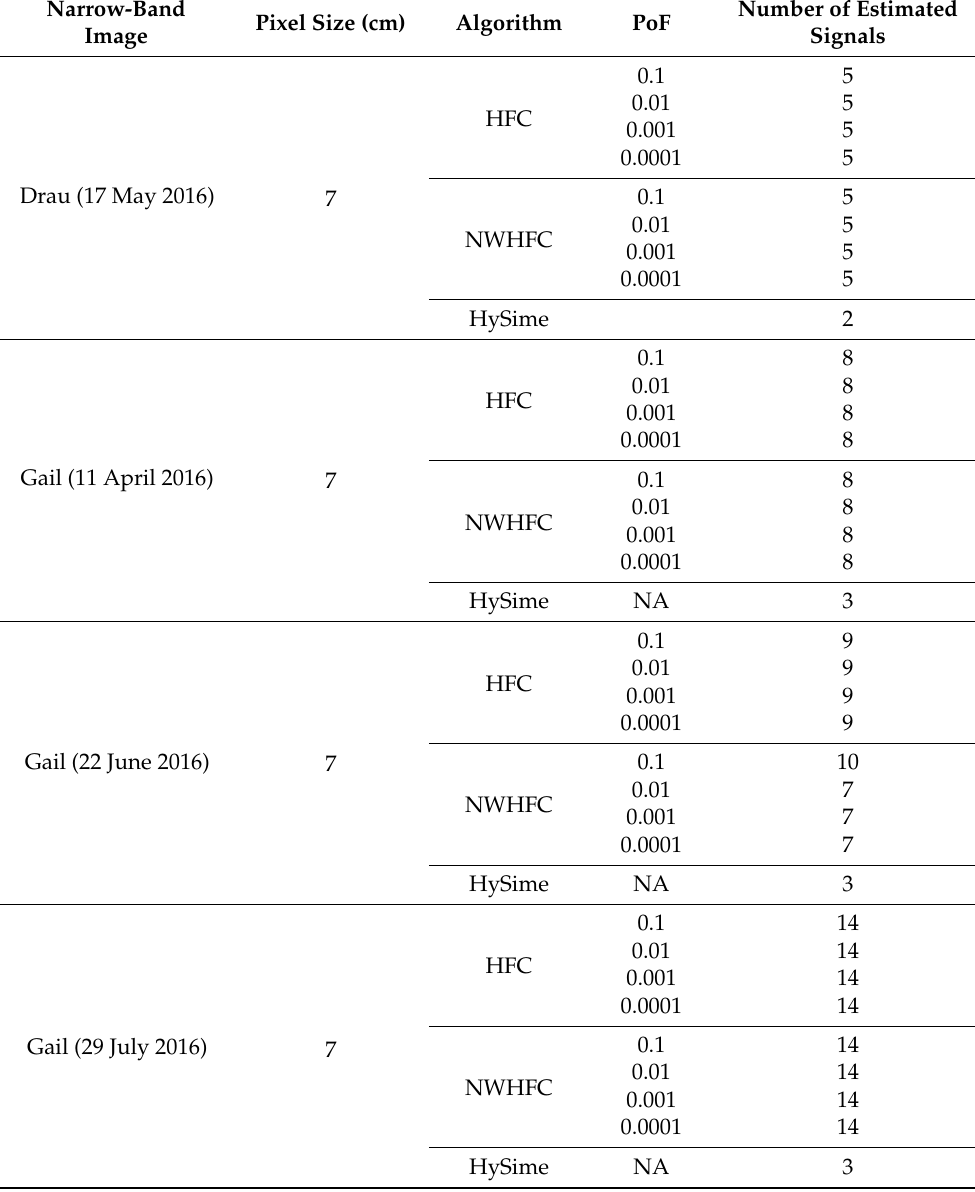
Table 5. The number of signals estimated by each algorithm and probability of failure (PoF) specifica- tion within each narrow-band image mosaic with 7 cm pixel size.